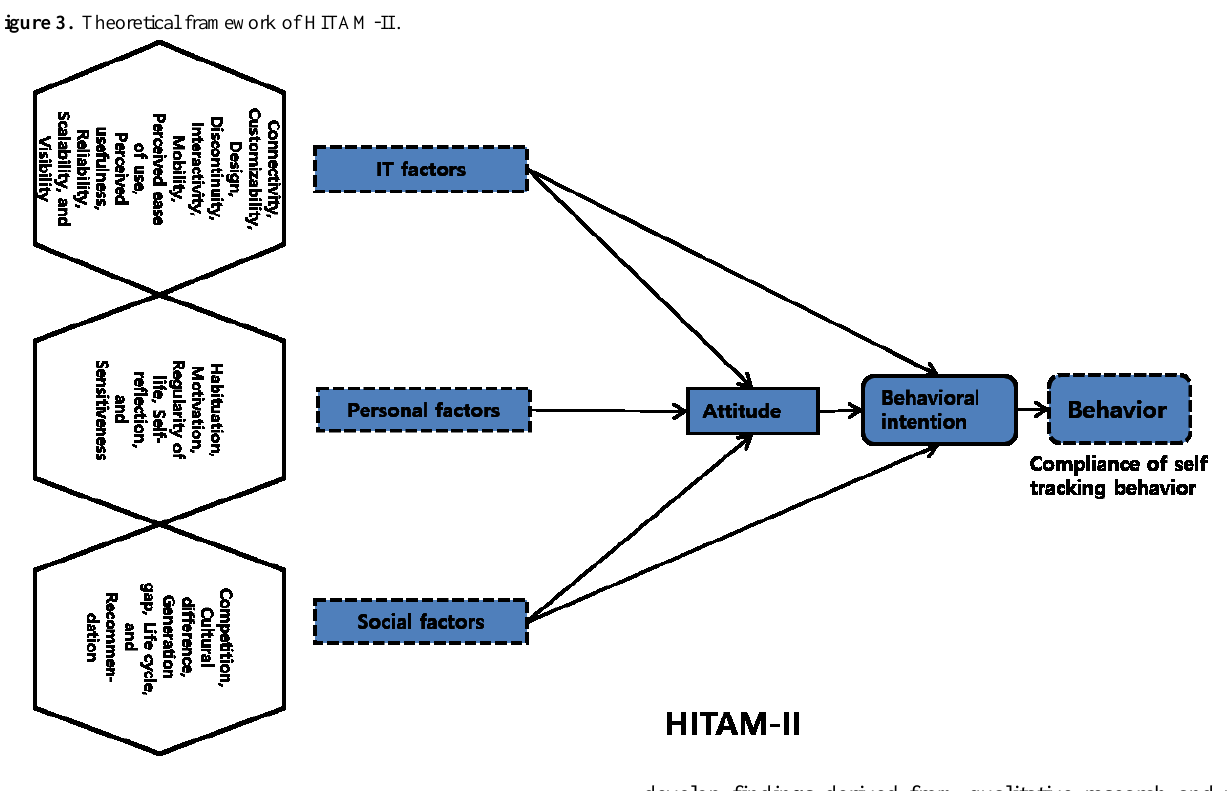
Figure 3. Theoretical framework of